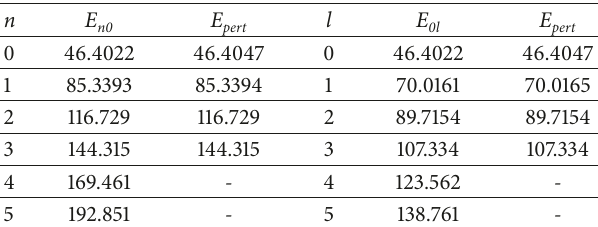
Table 3: Comparisons of the perturbative energy eigenvalues ( 𝐸 𝑝𝑒𝑟𝑡 ) (in GeV) with those obtained by direct application of AIM ( 𝐸 𝑛𝑙 ) for the potential parameters, 𝐴 = 1 and 𝐵 = 10 GeV, and for the reduced mass 𝜇 = 1/2